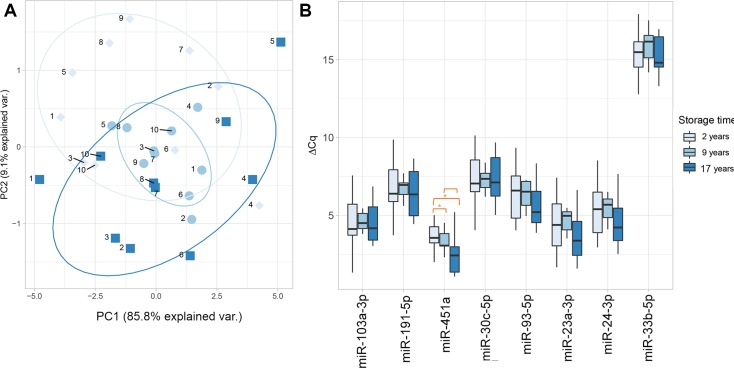
Effect of storage time on the expression levels of circulating miRNAs in plasma.Storage duration was one of 17 years, 9 years or 2 years. (A) Scatterplot of the first two principal component scores from the PCA analysis of storage time based on the data of the seven robustly measured miRNAs from the full sample (Nstorage = 10). Principal components one (shown on the x-axis) and two (y-axis) explain 85.80% and 9.10% of the data variance, respectively. Symbols and colors correspond to storage time to facilitate visual inspection, and a confidence ellipse for the population mean was drawn around the grouped observations in order to visualize the variance (data with higher variance creates larger confidence ellipses). (B) Boxplots of miRNA levels based on the data from the full sample (Nstorage = 10) for seven miRNAs and on a subset of the data with complete longitudinal observations for miR-33b-5p (N miR-33b-5p = 4). The lower and upper hinges of the box present the first and third quartiles (25th and 75th percentiles), and the whiskers extend to 1.5 * IQR (interquartile range) in both directions; data beyond the whiskers are plotted individually. The x-axis lists the name of the miRNAs, while the y-axis shows the miRNA quantification level, calculated as ΔCq normalized to the median level of the synthetic oligonucleotide UniSp6. Smaller ΔCq values denote greater miRNA levels and are characteristic of miRNAs commonly found in plasma, whereas larger ΔCq values are characteristic of miRNAs detected in low concentrations in the sample. MiRNA measurements corresponding to 17 storage years are shown in dark blue, those corresponding to 9 years are shown in blue, and those to 2 storage years in light blue. Pairwise comparisons are shown and significant differences as determined by Tukey’s test marked with a star.